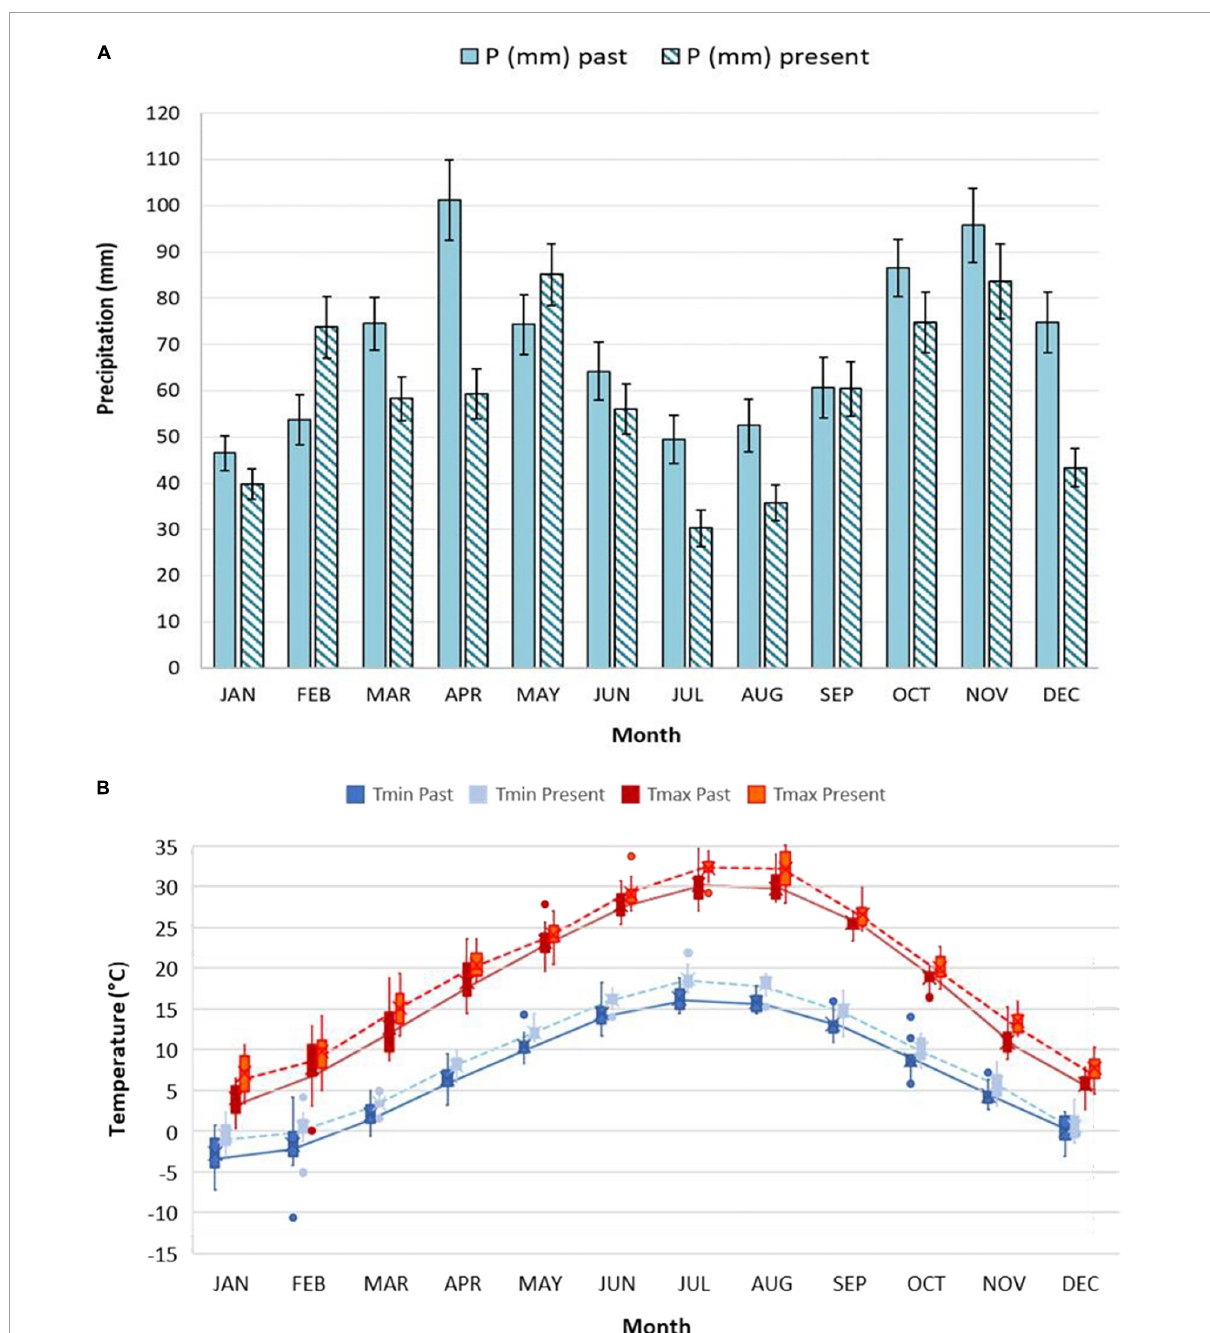
FIGURE3 Average monthly precipitation (A) and mean monthly T max and T min (B) for past and present period. Figures are both based on 15 years averaged data, gathered by Corticella-Cadriano continuous and uniform daily mechanical weather data historical series, in the Experimental Farm of the University of Bologna. Boxplots for monthly temperatures data are presented: the box goes from first to the third quartile. The line through the box represents the median. The whiskers go from each quartile respectively to the minimum and maximum value. Individual points outside the ends of the whiskers are